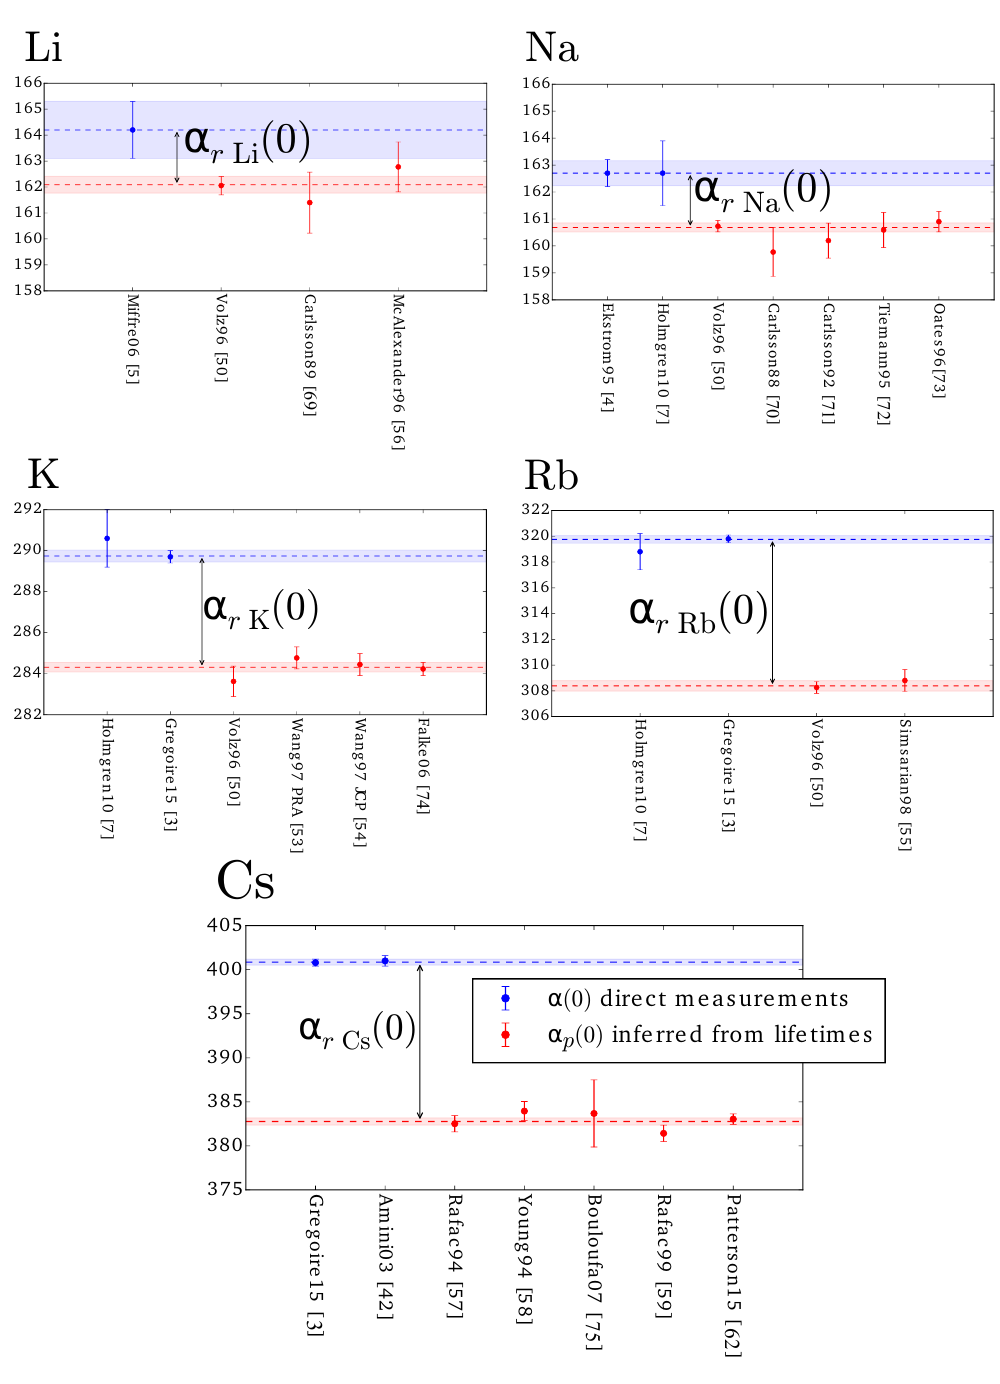
Figure 7. Differences between recent α ( 0 ) measurements [3–5,7,42] and an average of α p ,Cs values calculated from lifetime measurements [50,53–59,62,69–75] and R values [12,18,50–52]. The uncertainties on those averages are used to calculate the resulting uncertainties in α r ( 0 )